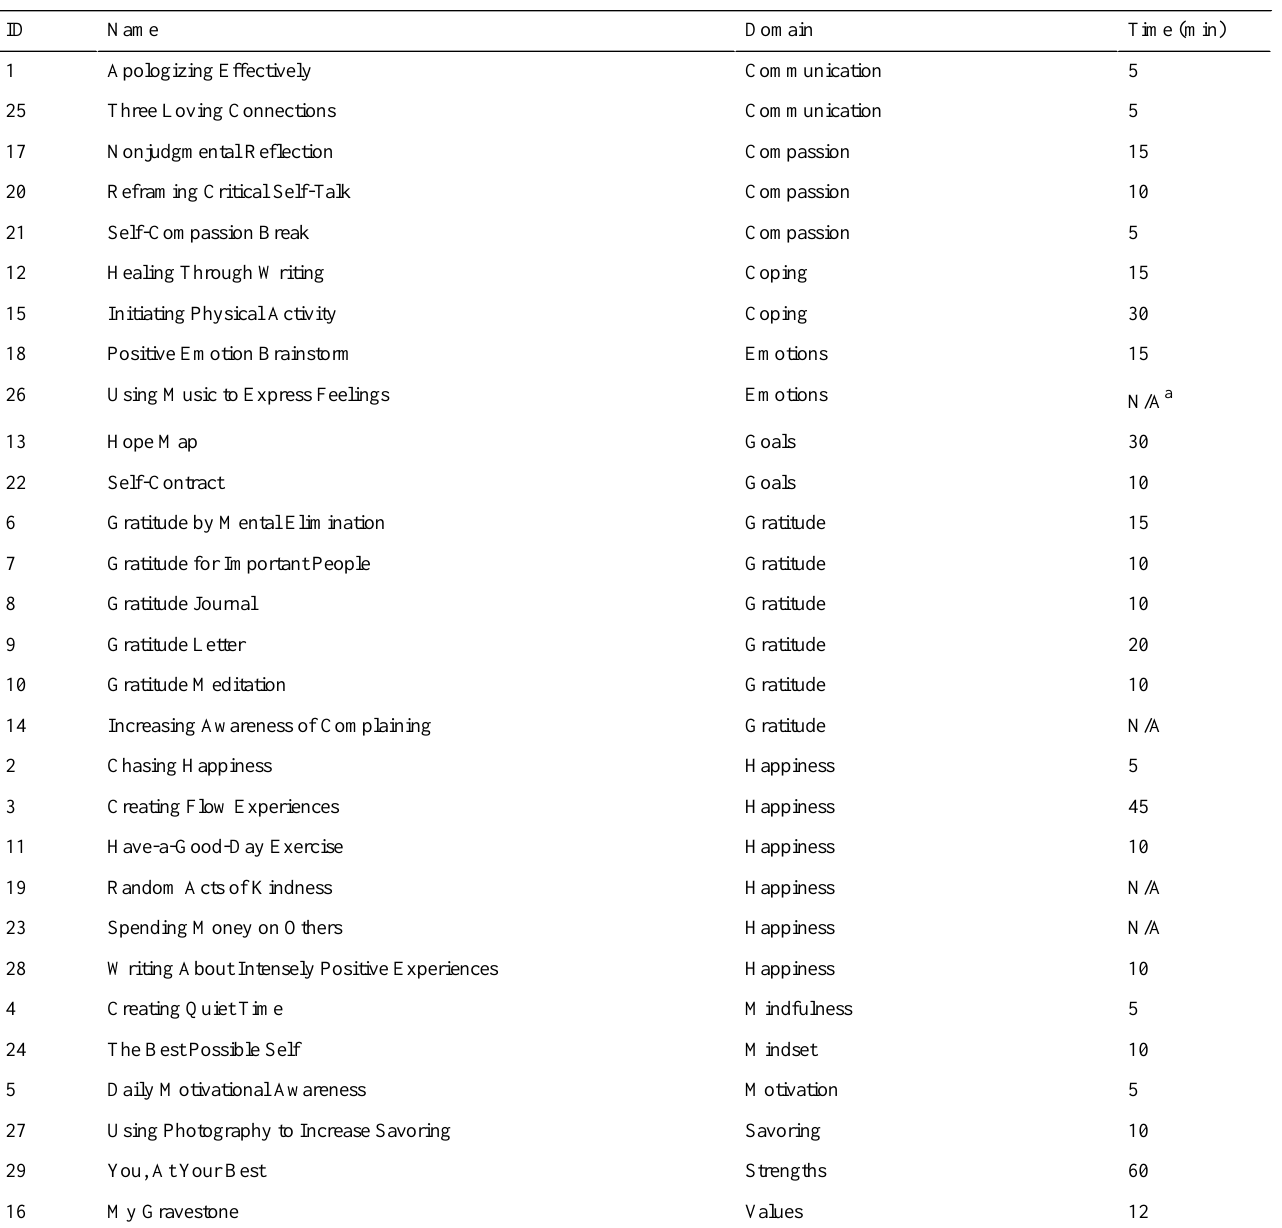
Table 2. Interventions.